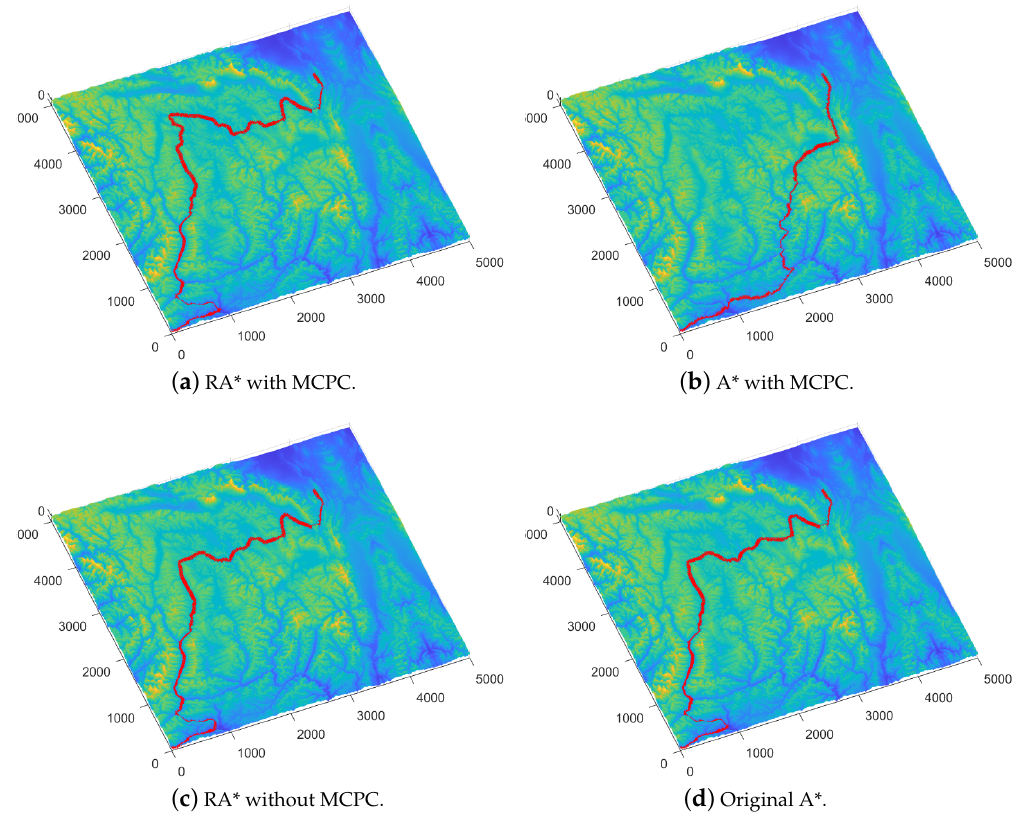
Figure 12. Experiments of RA* and MCPC.